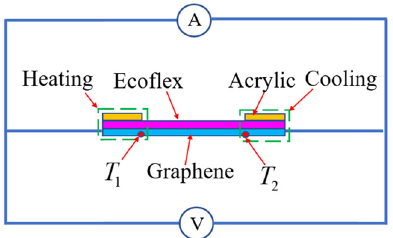
Figure 9: Schematic of the self - powered thermoelectric device made of graphene - based eco fl ex composite fi lm for measuring the output voltage and current under the thermal gradient ( Δ T = T 1 − T 2 ) . T 1 denotes the temperature at the point of the heating side; T 2 denotes the temperature at the point of the cooling